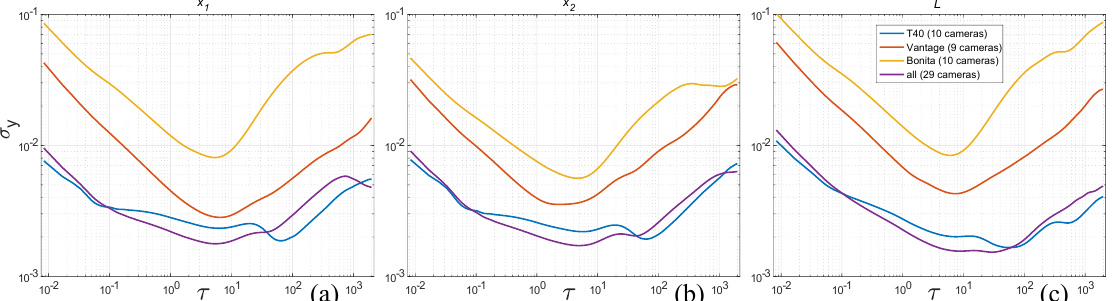
Figure 13. ADEV for maximal numbers of cameras of each type separately and altogether for: ( a ) position x 1 , ( b ) position x 2 , ( c ) distance L